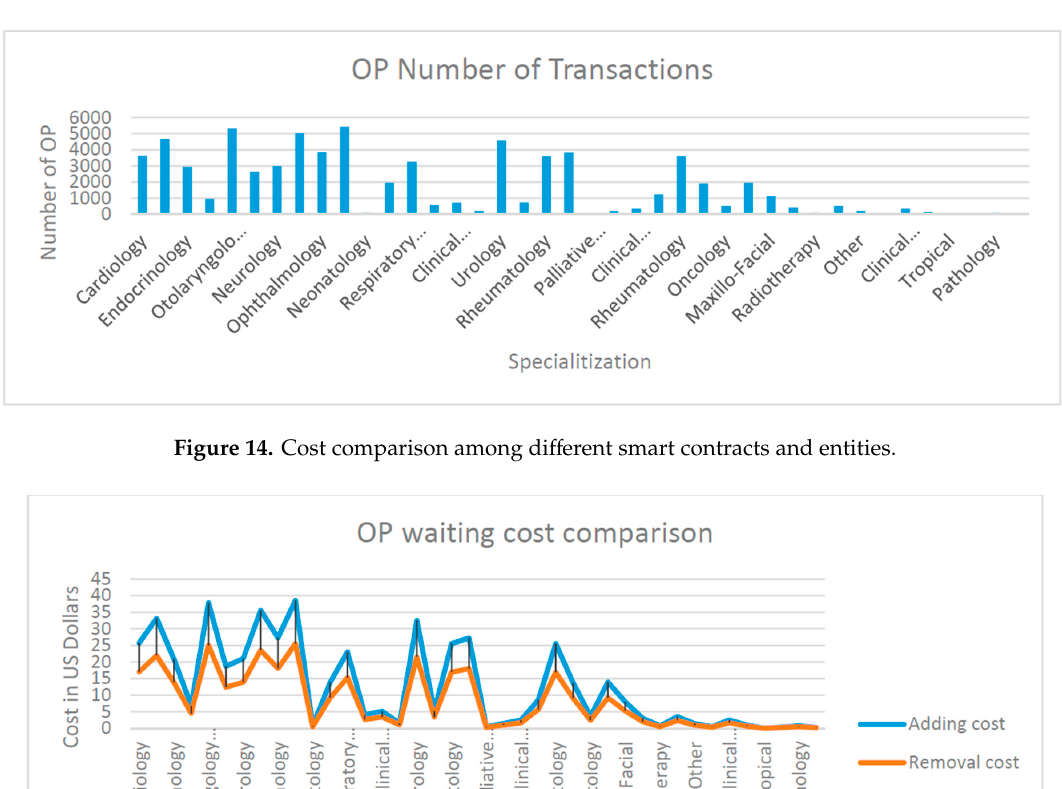
Figure 13. Plot showing smart contract deployment cost for countywise pharmacies in Ireland.